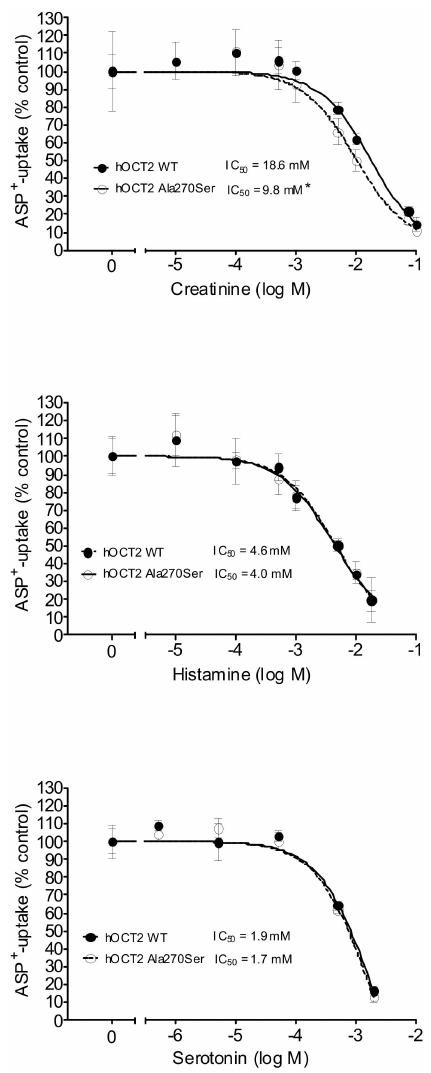
Figure 2. This figure shows the inhibition of ASP + uptake (mean ± standard error of the mean (SEM)) by creatinine (upper panel, 6–72 replicates for each concentration), histamine (middle panel, 12–36), and serotonin (lower panel, 6–18) in hOCT2 WT ( (cid:8) , continued line) and hOCT2 Ala270Ser ( cells, measured in at least 3 independent experiments. For every substance, a concentration-dependent inhibition of ASP + uptake was observed. The calculated IC 50 values are also reported in the figures. The IC 50 of creatinine was significantly di ff erent between hOCT2 WT and hOCT2 Ala270Ser (*) when compared using the extra sum-of-squares F test (GraphPad Prism), with the mutated transporter having a higher a ffi nity for the